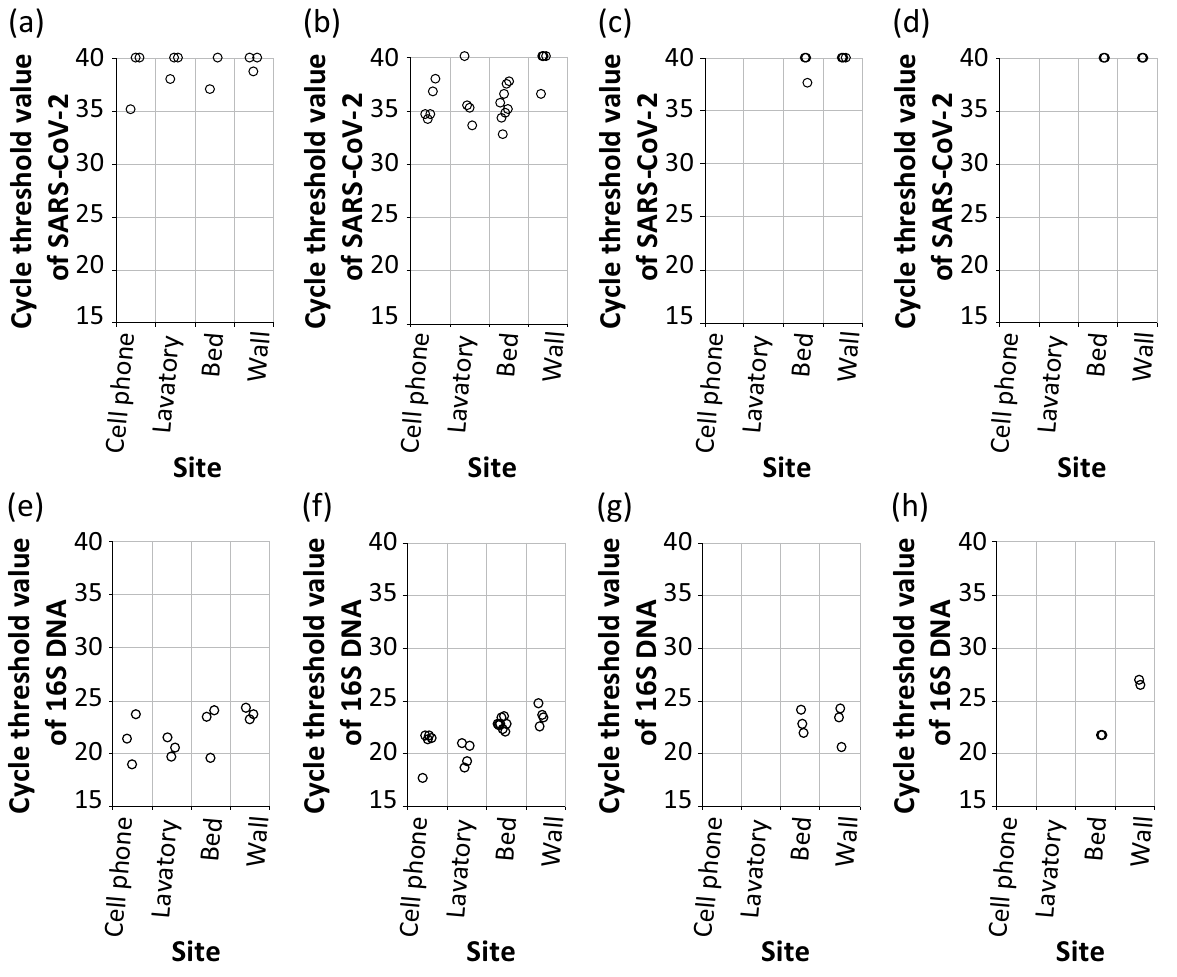
Fig. 5 RT‑qPCR results of SARS‑CoV‑2 and qPCR results of total bacteria in environmental samples collected from surfaces in various negative pressure COVID‑19 patient wards; a , e single‑person negative pressure wards in which patients can move; b , f double‑shared (two‑person) negative pressure wards (patients can move); c , g single‑person negative pressure wards within an intensive care unit (patients with nasal cannula unit cannot move); d , h single‑person negative pressure wards within an intensive care unit (patients with extubation unit cannot